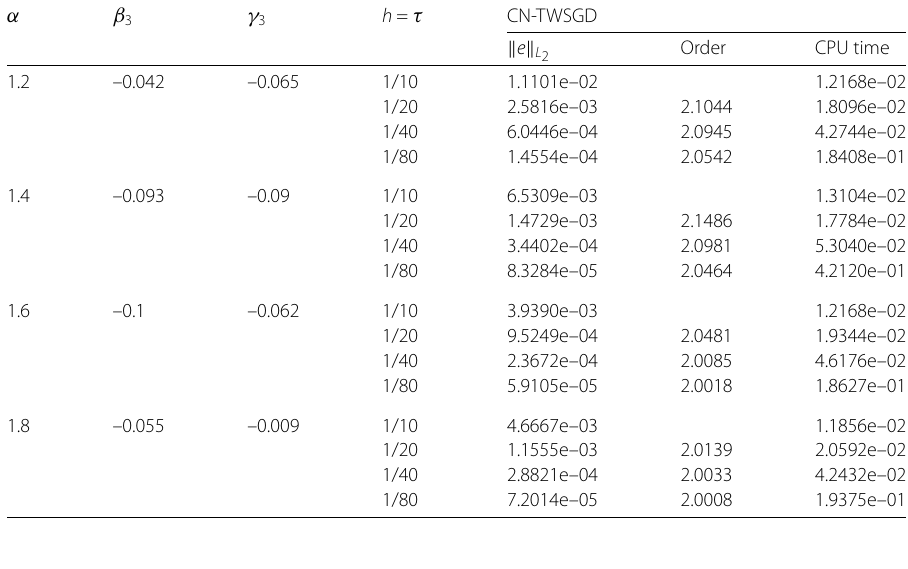
Table 6 Errors and corresponding observation orders at t = 1, λ =